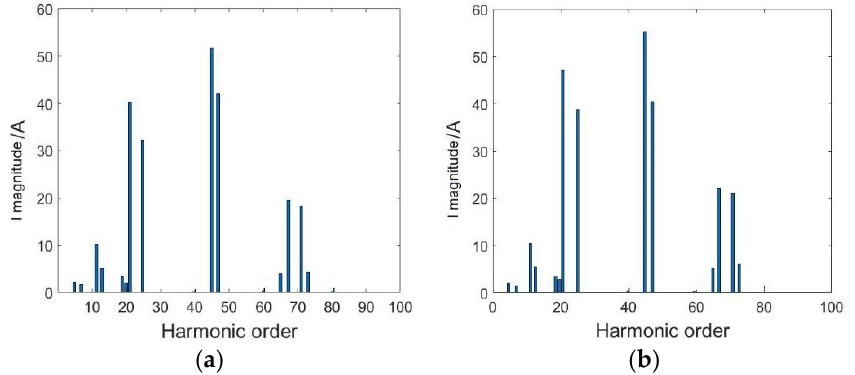
Figure 1. Harmonic component of winding current of phase A under different slot openings: ( a ) slot opening = 2.0 mm and ( b ) slot opening = 7.0 mm.